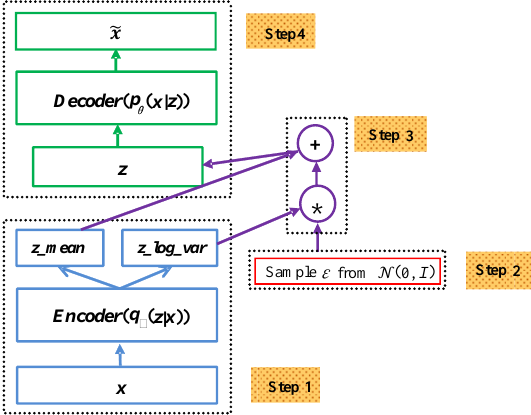
Figure 2. The architecture and operation flows of a VAE .